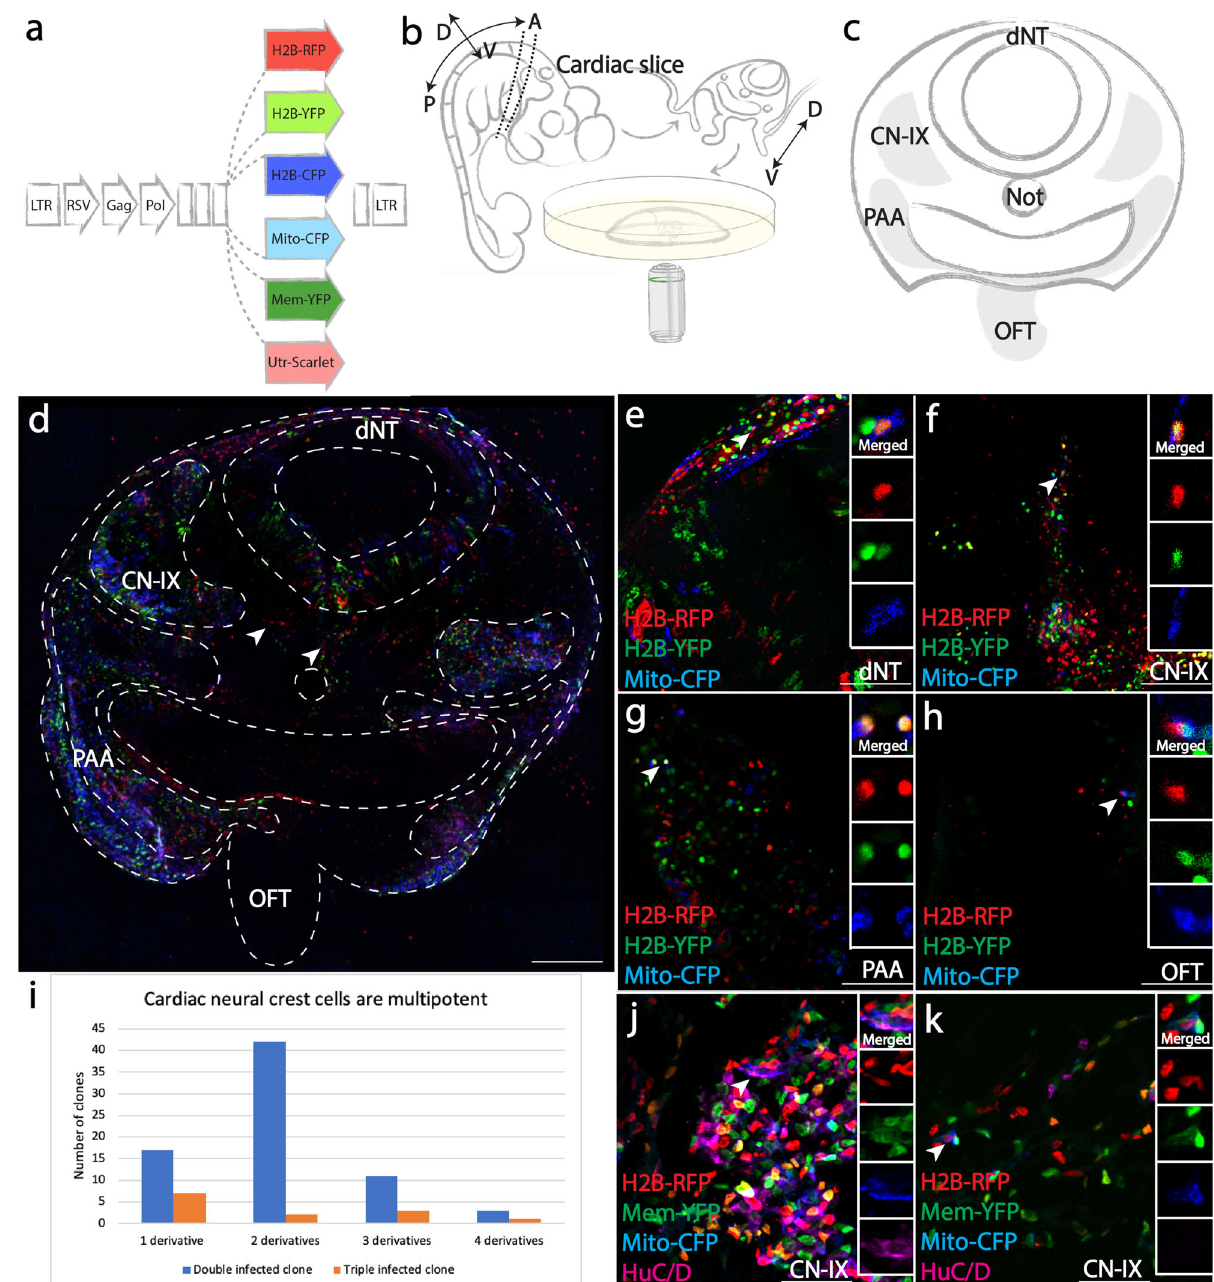
Fig. 1 Multiplexed clonal analysis demonstrates multipotency of premigratory cardiac neural crest cells. a Sequences encoding H2B-RFP, H2B-YFP, H2B-CFP, Mito-CFP, Mem-YFP, and Utrophin-Scarlet were cloned downstream of the RSV promoter of the RIA vector for combinatorial infection. b Schematic diagram of in vivo slice culture. At HH21, a ~500 μ m thick slice was obtained posterior to the otic placode. The slice was then embedded in 1% agarose and imaged using inverted confocal microscopy. A, anterior; P, posterior; D, dorsal; V, ventral. c Schematic diagram of cardiac neural crest-derived tissues (gray). Dorsal neural tube (dNT), cranial nerve nine (CN-IX), pharyngeal arch arteries (PAA) and out fl ow tract (OFT) were imaged and scored for cells with identical clonal signatures. d A tiled multiplex image of the cardiac slice, representative of 23/23 embryos. CN-IX, PAA, OFT and Schwann cells (arrowhead) were infected by a mixture of RIAs. Red signal along the pharyngeal endoderm is auto fl uorescence from tissue debris common in chick explant cultures. e – h Clonally related cells (ID: Supplementary Data 1a-84) infected by three viruses (H2B-RFP, H2B-YFP, Mito-CFP, arrowhead) were identi fi ed in all four cardiac neural crest derivatives: dNT ( e ), CN-IX ( f ), PAA ( g ), OFT ( h ). In ( h ), RFP and YFP signals did not align in the OFT as a result of heart beating during image acquisition. i Bar graph showing distribution of double (blue) and triple (orange) infected clones. j , k In clones that appeared to be restricted in one location, cells could acquire distinct fates. At E7, one cell in a rare clone near CN-IX expressing H2B-RFP, Mem-YFP and Mito-CFP differentiated into HuC/D expressing neuron ( j ), while another cell of the same clone remained HuC/D negative ( k ). Scale bars: d 500 μ m; e – h 100 μ m; j , k 60 μ m.